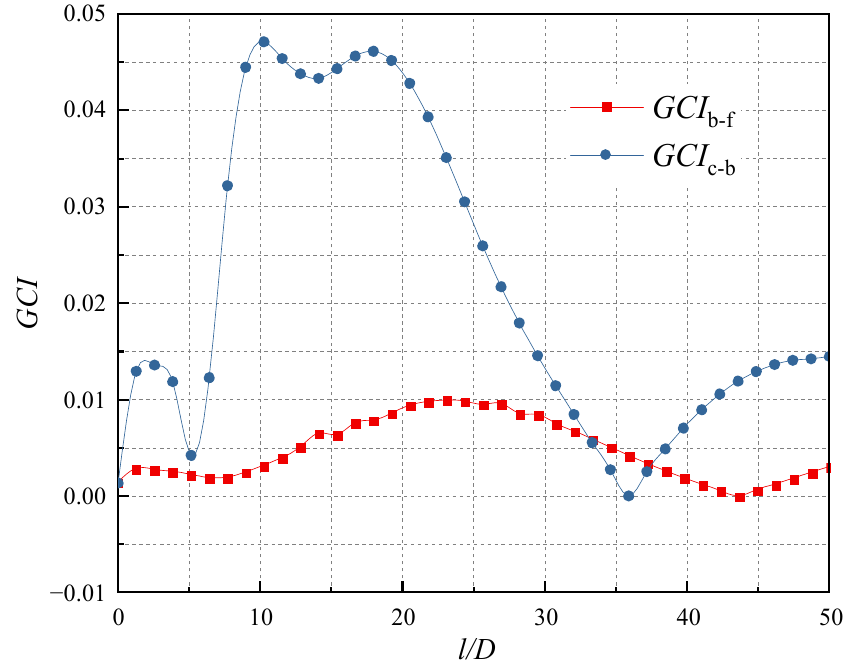
Figure 3. GCI distribution of numerical simulation results.